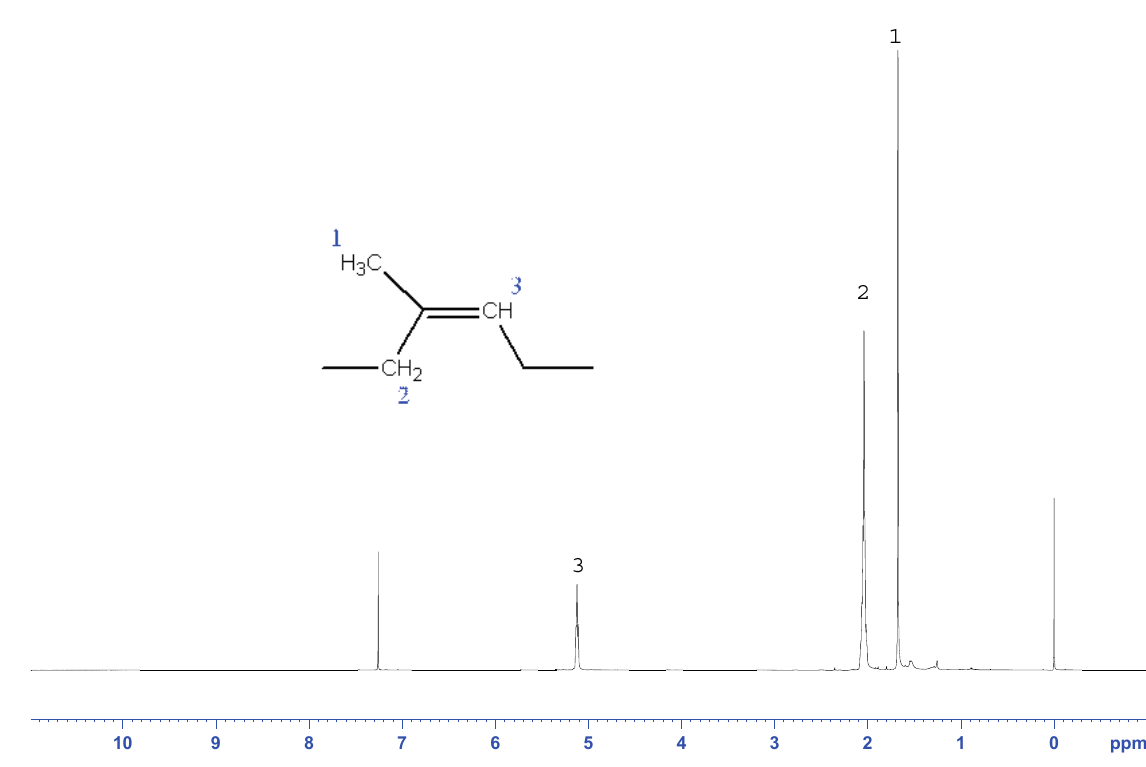
Figure 5. 1 H NMR spectrum of NR.